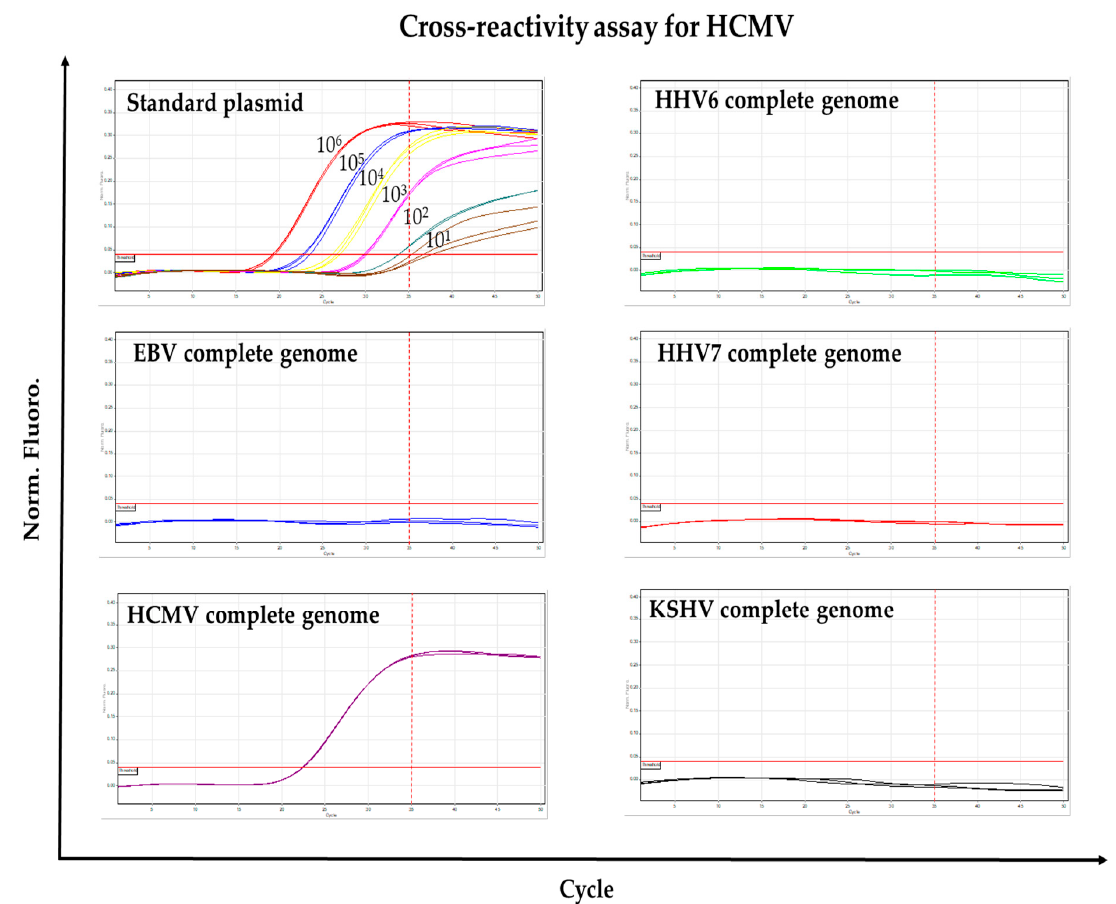
Figure 3. Cross-reactivity assay for HCMV. The primers and fluorescent probe used for detecting HCMV were tested for cross-reactivity with the other viruses (as is indicated in the top of each panel). Positive fluorescent signal was only detected when HCMV DNA or serial dilutions (10 6 –10 1 ) of HCMV standard plasmid were used as template. For all panels, amplification cycle (Cycle) is shown in the X axis, while the normalized fluorescence (Norm. Fluoro.) is shown in the Y axis. Horizontal red lines indicate the Cycle Threshold. Dotted vertical red lines indicate the LOD. Similar results were obtained for EBV, HHV6, HHV7 and KSHV (Supplementary Figure S1).